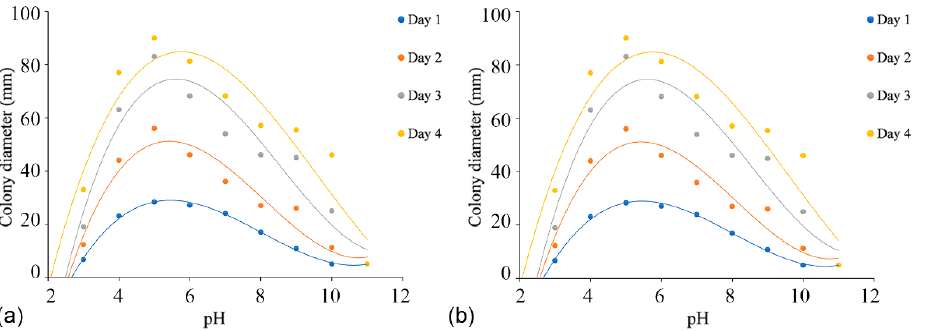
Figure 7. Effects of pH on the growth of Cytospora species. ( a ) Cytospora alba (CFCC 55462): y Day1 = 0.3546x 3 − 8.5492x 2 + 61.603x − 110.27 (R 2 = 0.9957); y Day2 = 0.5799x 3 − 14.068x 2 + 101.43x − 177.67 (R 2 = 0.9252); y Day3 = 0.6425x 3 − 16.478x 2 + 124.19x − 217.02 (R 2 = 0.8945); y Day4 = 0.4139x 3 − 11.886x 2 + 95.703x − 151.21 (R 2 = 0.8693). ( b ) Cytospora paracinnamomea (CFCC 55453): y Day1 = 0.2383x 3 − 5.3296x 2 + 35.599x